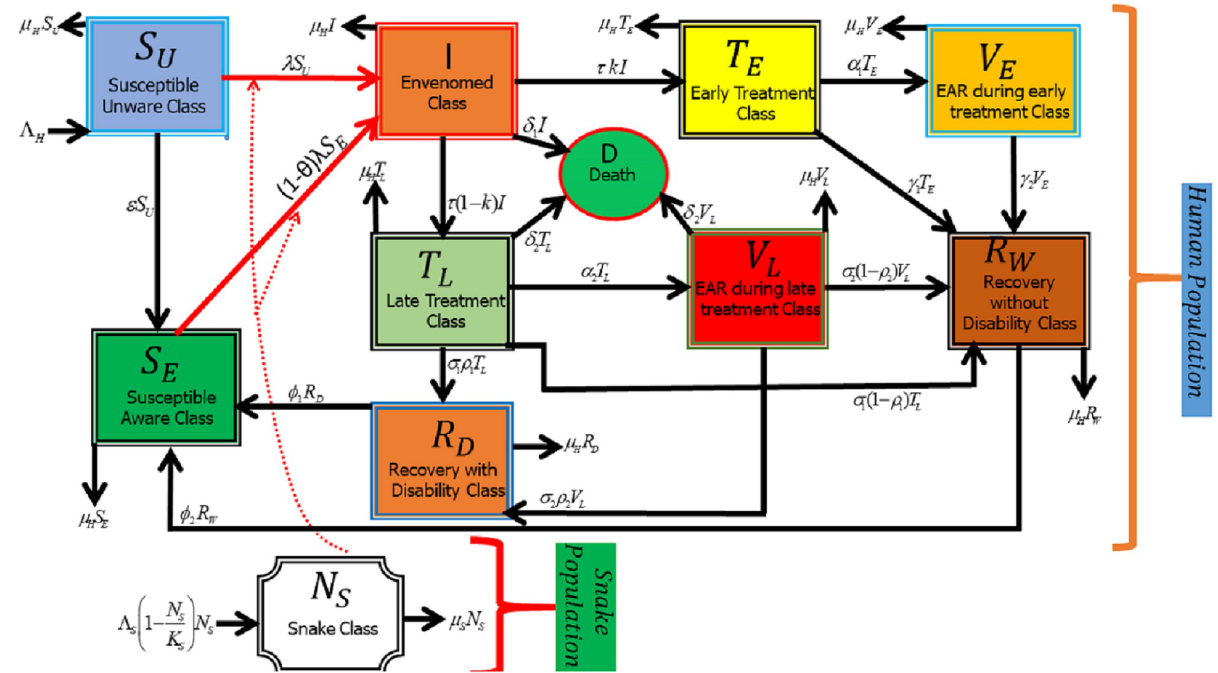
Fig 1. Schematic diagram of the model. The diagram describe the movement of individuals from one state to another.